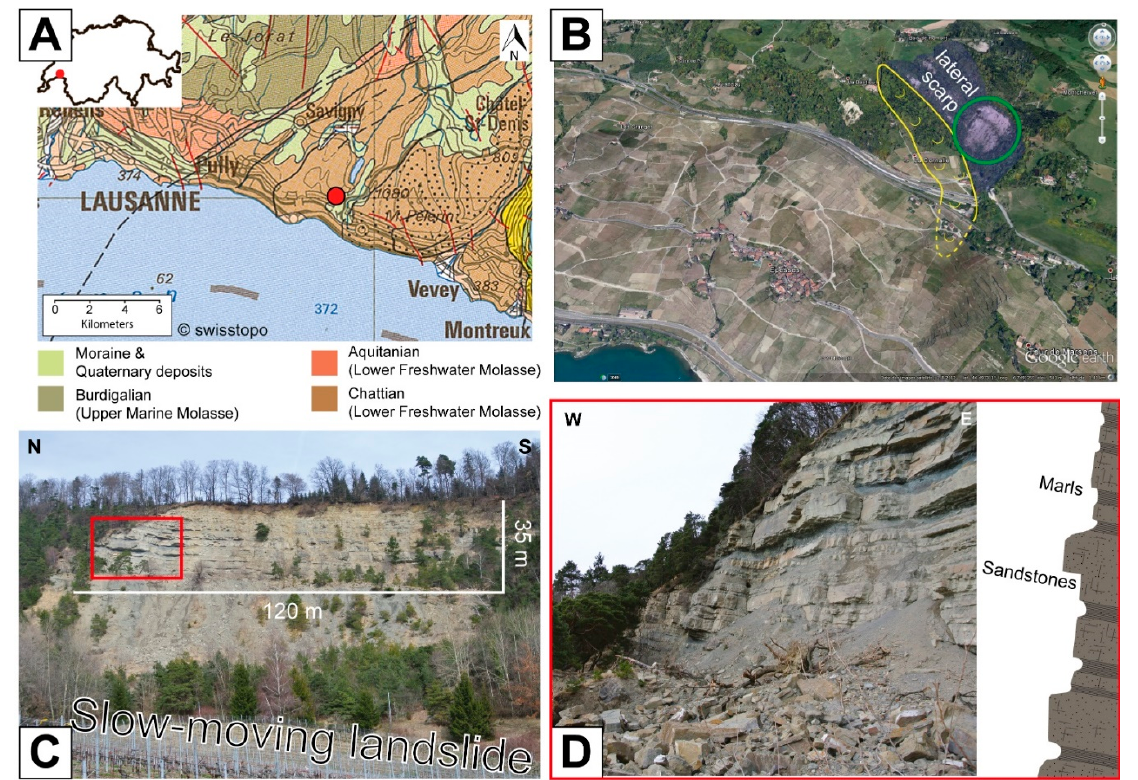
Figure 5. ( A )Map of the geological setting of western Switzerland. Red dots indicate the location of the study area in the Molasse Swiss Plateau near Lausanne. ( B ) La Cornalle cliff is the lateral scarp (green circle) of the slow-moving landslide indicated in yellow. ( C ) Overview of La Cornalle cliff on top of a slow-moving landslide. ( D ) A closer view of the cliff shows the lithology of the area composed of alternating metric layers of sandstone and marls. Source map from Swisstopo and orthophoto from Google Earth.